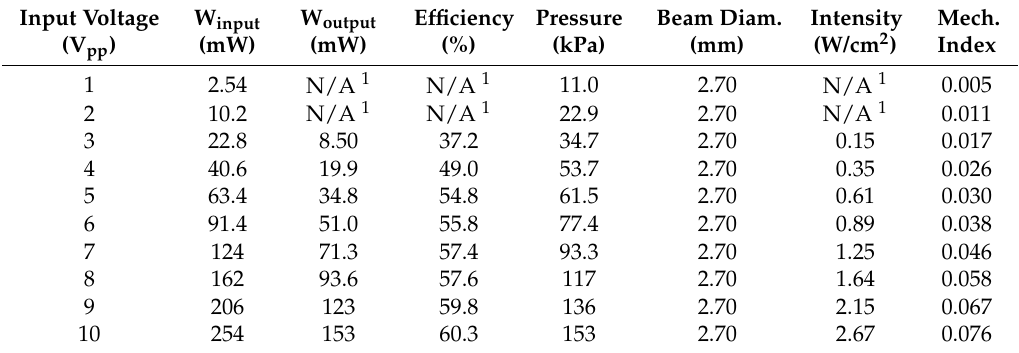
Table 3. Output parameters of miniature focused-US transducer with central frequency f = 4 MHz and 1 mm central delivery